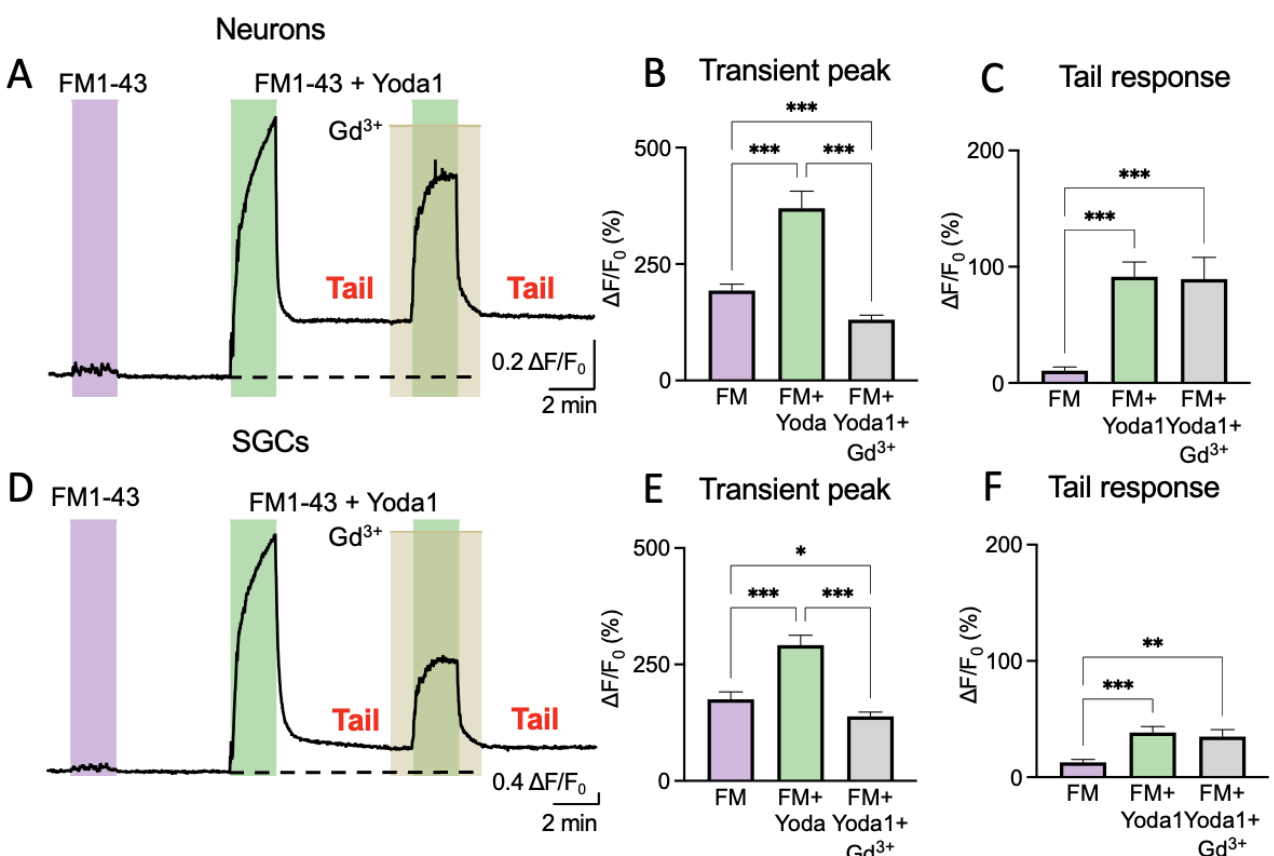
Figure 3. Trigeminal cell FM1-43 long-lasting labelling is mediated by Piezo1 activation. ( A ). Sample trace of fluorescence intensity variations in trigeminal neurons induced by 2 μM of FM1-43 followed by 2 μM of FM1- 43 + 25 μM of Yoda1 and, in the end, 2 μM of FM1- 43 + 25 μM of Yoda1 + 100 μM of Gadolinium (Gd 3+ ). Important elements are the transient peak, showing the acute treatment response, and the tail response, addressing long-lasting dye internalization. ( B ). Percentage of increased fluorescence intensity in trigeminal neurons. The increase in the transient peak was normalized to baseline during the application of FM1- 43 followed by 2 μM of FM1- 43 + 25 μM of Yoda1 and, in the end, 2 μM of FM1- 43 + 25 μM of Yoda1 + 100 μM of Gadolinium (Gd 3+ ). The transient peak was higher only when both FM1-43 and Yoda1 were applied (mixed effect analysis with Tuckey post-hoc test, *** p < 0.001). ( C ). Percentage distribution of increased tail response levels in neurons normalized to the initial baseline after 2 μM of FM1- 43 followed by 2 μM of FM1-43 + 25 μM of Yoda1 and, in the end, 2 μM of FM1- 43 + 25 μM of Yoda1 + 100 μM of Gadolinium (Gd 3+ ). The tail response was higher only when both FM1-43 and Yoda1 were applied (mixed effect analysis with Tuckey post-hoc test, *** p < 0.001). ( D ). Sample trace of fluorescence intensity variations in SGCs induced by 2 μM of FM1- 43 followed by 2 μM of FM1- 43 + 25 μM of Yoda1 and, in the end, 2 μM of FM1- 43 + 25 μM of Yoda1 + 100 μM of Gadolinium (Gd 3+ ). Important elements are the transient peak, showing the Yoda1 response, and the tail response, addressing long-lasting dye internalization. ( E ). Percentage of increased fluorescence intensity in SGCs. An increase in the transient peak was normalized to baseline during the application of 2 μM of FM1-43 followed by 2 μM of FM1- 43 + 25 μM of Yoda1 and, in the end, 2 μM of FM1- 43 + 25 μM of Yoda1 + 100 μM of Gadolinium (Gd 3+ ). The transient peak was higher only when both FM1-43 and Yoda1 were applied (mixed effect analysis with Tuckey post-hoc test, * p= 0.037, *** p < 0.001). ( F ). Percentage distribution of increased tail response levels in SGCs normalized to the initial baseline after the application of 2 μM of FM1- 43 followed by 2 μM of FM1- 43 + 25 μM of Yoda1 and, in the end, 2 μM of FM1-43 + 25 μM of Yoda1 + 100 μM of Gadolinium (Gd 3+ ). The tail response was higher only when both FM1-43 and Yoda1 were applied (mixed effect analysis with Tuckey post-hoc test, ** p= 0.001, *** p< 0.001).